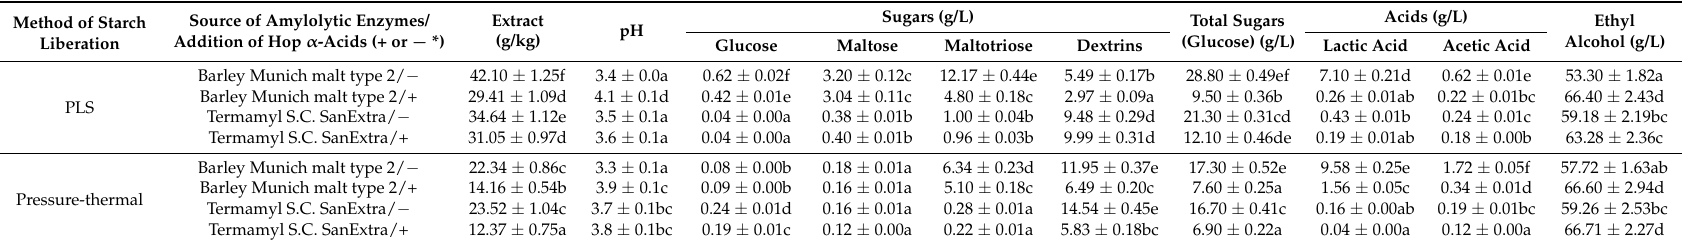
Table 3. Chemical composition of fermented